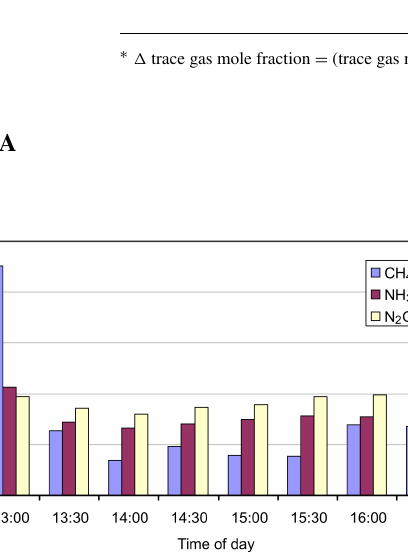
Figure A1. Ratio of predicted to known flux for ground-level 25 × 25m area source (source 3), using OP-FTIR mole fractions and measurement path 2 on 2 August 2005.